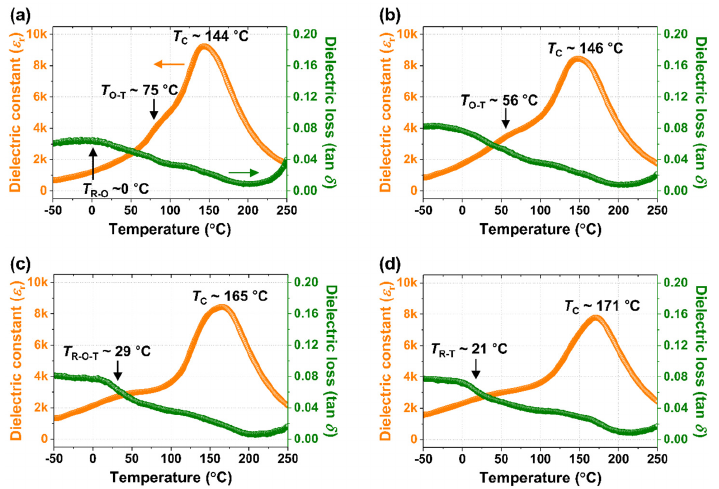
Figure 7. The ε r versus temperature curves obtained for the textured NKNS-(0.04 − x)SZ-xBAZ thick films with ( a ) x = 0.0, ( b ) x = 0.01, ( c ) x = 0.03, and ( d ) x = 0.04. However, the d 33 value decreased when x was > 0.02. Hence, it can be proposed that the variation in d 33 with respect to x was similar to the k p value. Moreover, the highest piezoelectricity ( d 33 = 760 ± 20 pC/N and k p = 0.58) was observed for the textured